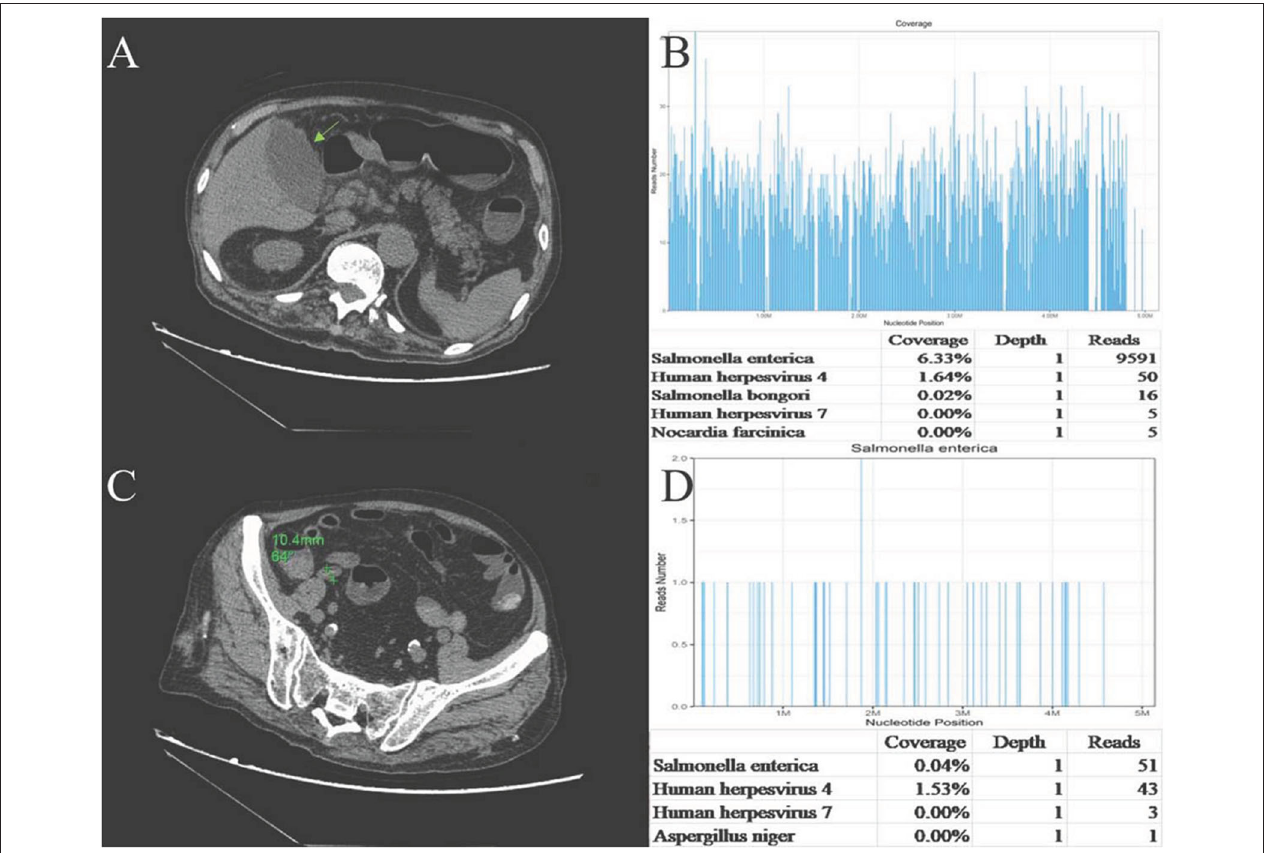
FIGURE 1 | (A) Abdominal CT plain: the gallbladder enlarged, and gallbladder wall was thickened and blurred. (B) Abdominal CT plain: The appendix cavity thickened, and the widest diameter was ∼ 11mm. (C) Sequencing of Salmonella yielded a total coverage of 6.33% in the gallbladder tissue by NGS. Number of unique reads, coverage, and depth of the identified pathogen sequences. The obtained sequence information was compared and analyzed with the known microbial database of NCBI gene bank to determine the type and content of microorganisms in the sample. The more segments detected, the more coverage, and the more reliable the result. (D) Sequencing of Salmonella yielded a total coverage of 0.04% in the appendix tissue by NGS. Number of unique reads, coverage, and depth of the identified pathogen